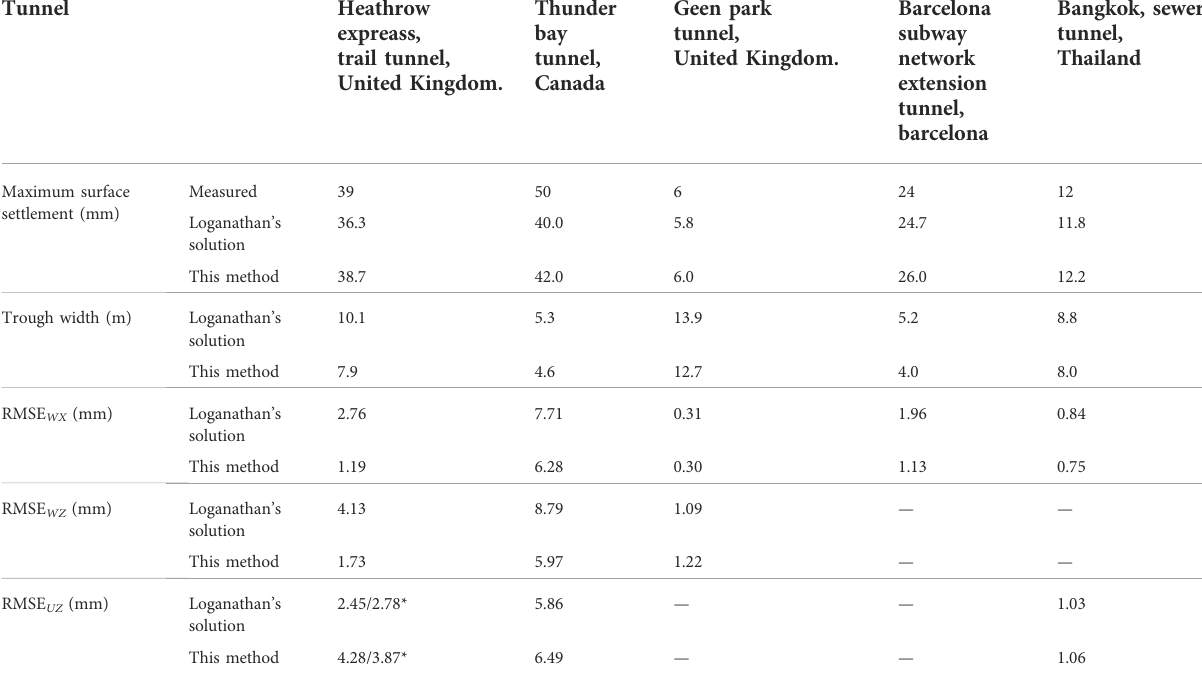
TABLE 3 Comparison of predicted and measured soil deformation parameters.